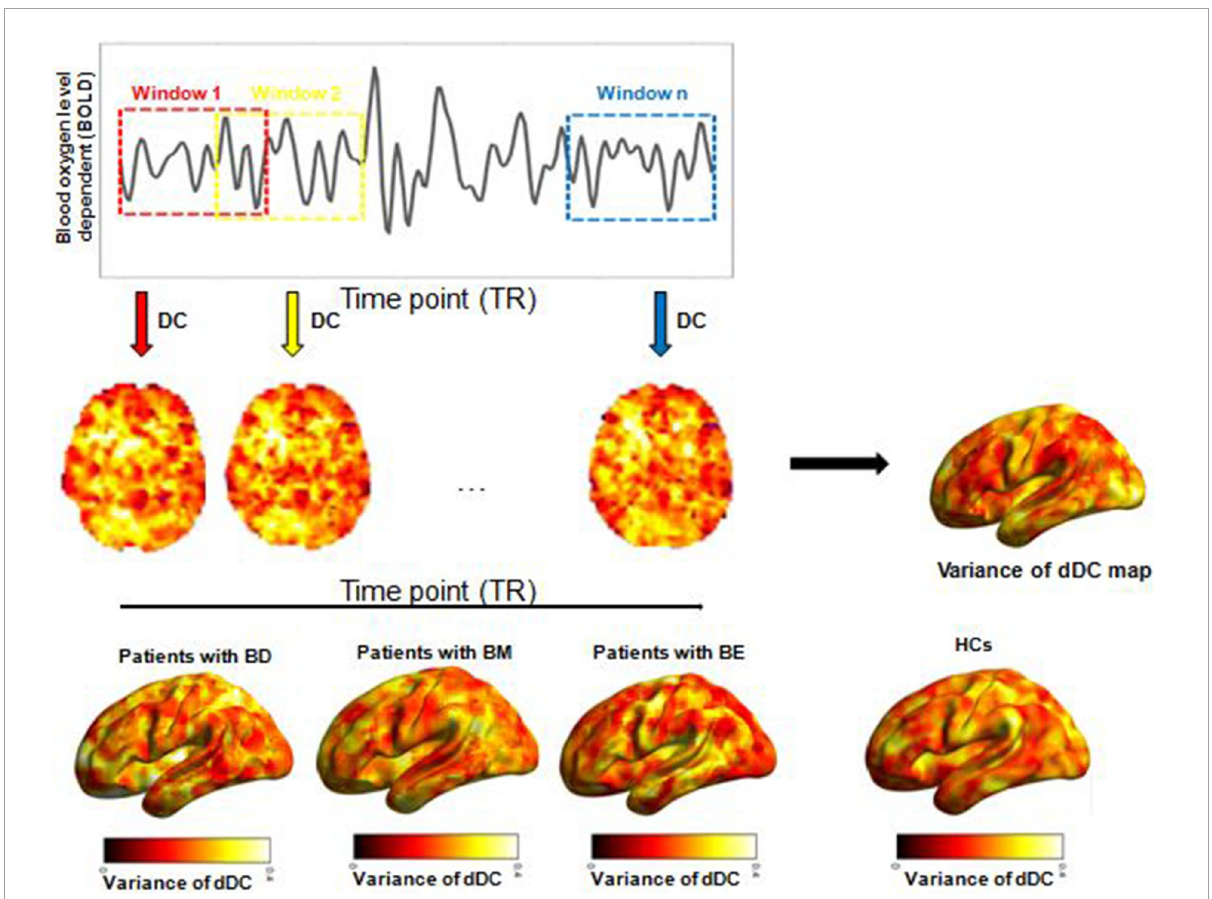
FIGURE1 Illustration of analysis steps. dDC, dynamical degree centrality; BD, bipolar depression; BM, bipolar mania; BE, bipolar euthymia; HCs, healthy